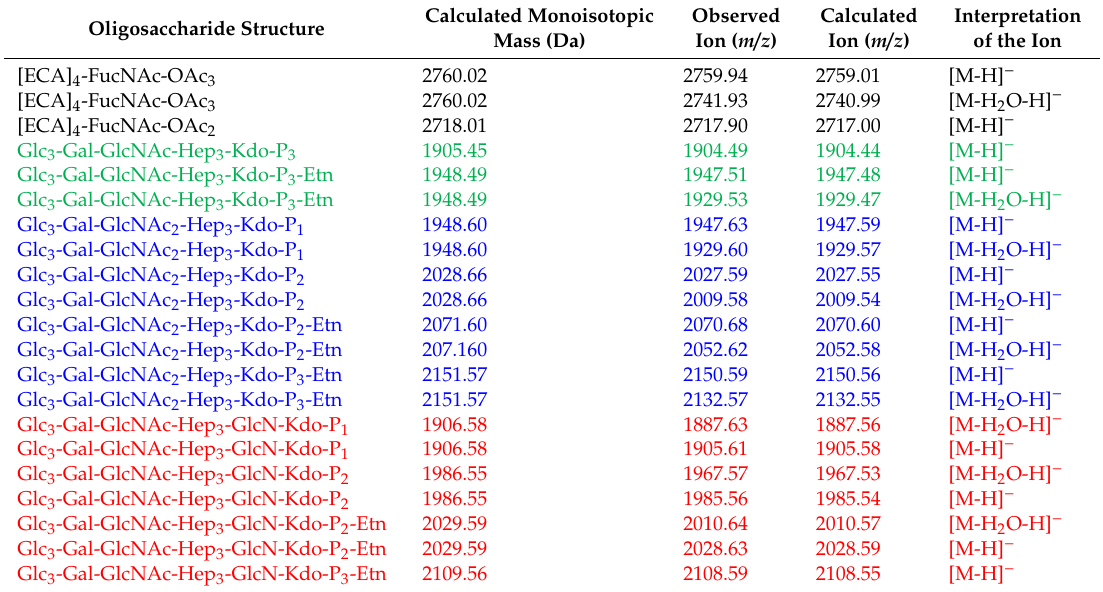
Table 5. Interpretation of negative-ion mode MALDI-TOF mass spectra of fraction 5 isolated from E. coli R3 LOS preparation.